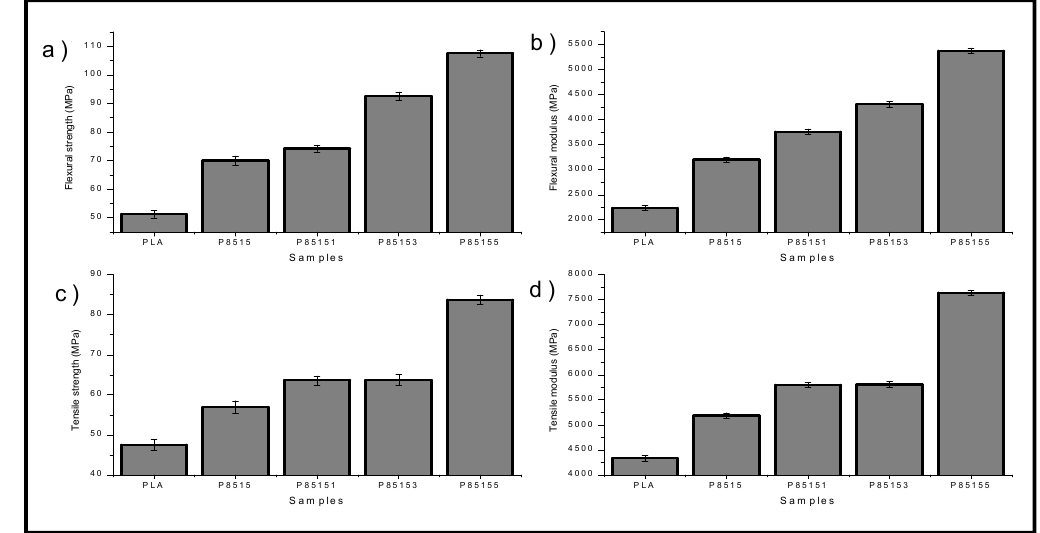
Figure 6. Mechanical properties ( a ) Flexural strength, ( b ) Flexural modulus, ( c ) Tensile strength, ( d ) Tensile modulus for neat PLA, P8515, P85151, P85153, and P85155 biocomposites.